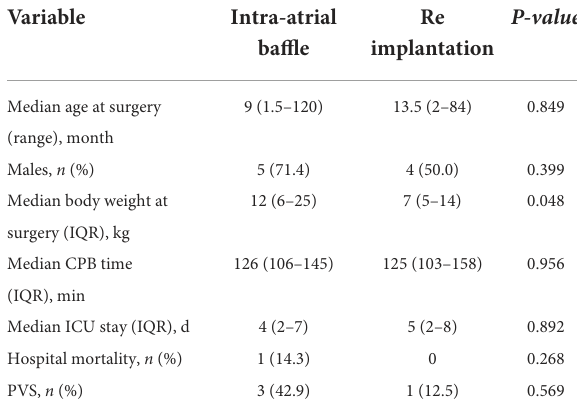
TABLE 2 Different lesions of anomalous pulmonary venous drainage. TABLE 3 Patients’ outcomes according to different surgical